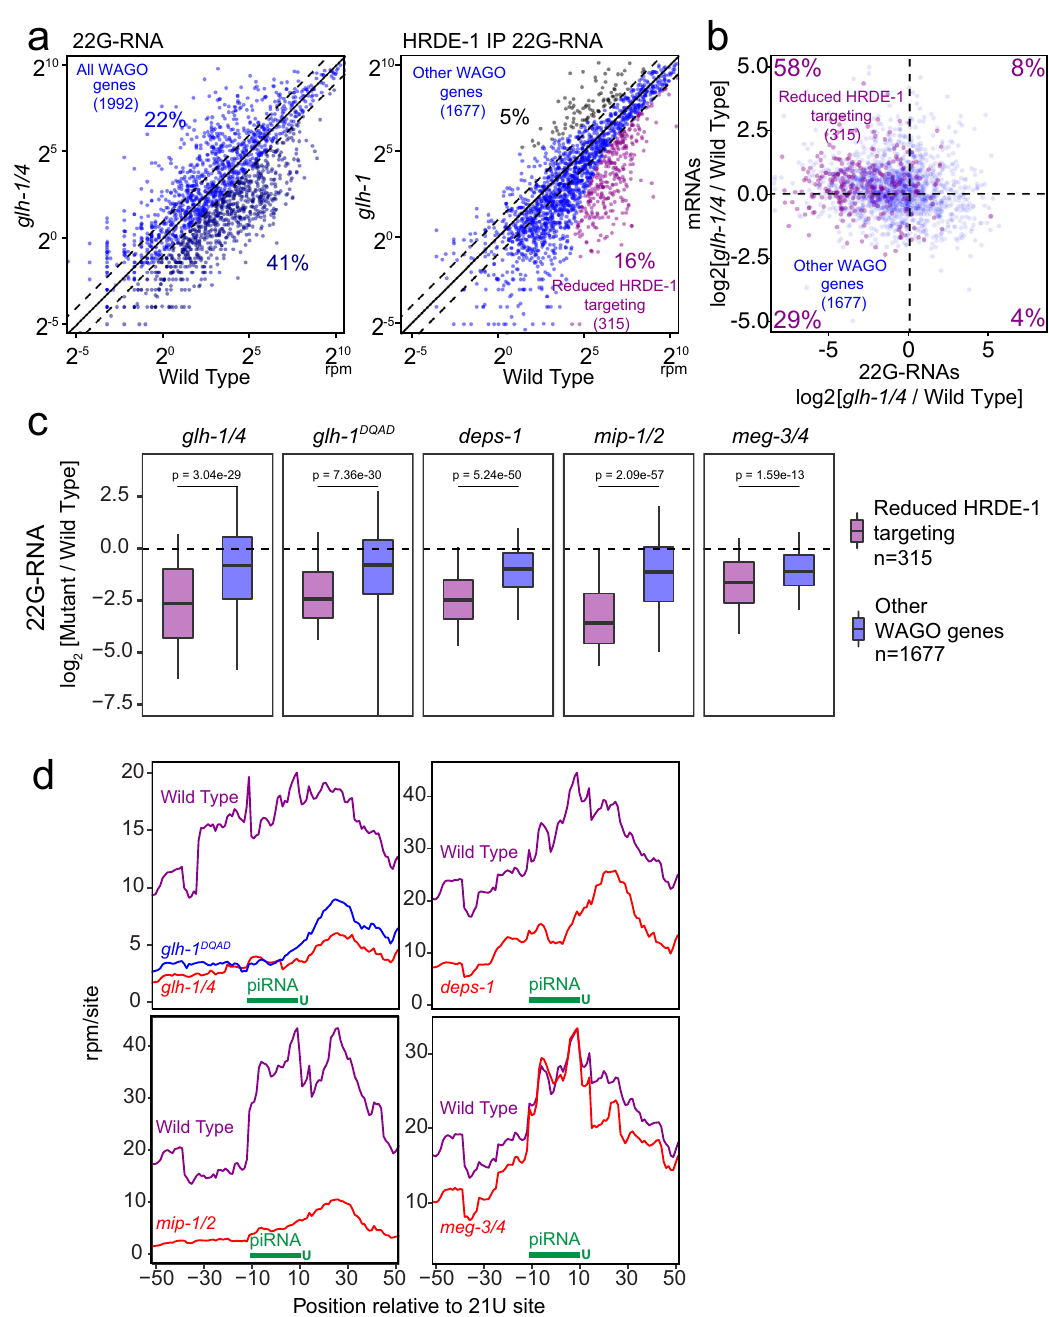
Fig.4|GLH/VASAmutantsexhibitdefectsinproducingsecondaryWAGO-22G- RNAs. a A scatter plot showing the abundance of all 22G-RNAs (left) or HRDE-1 bound 22G-RNAs (right) mapped to each WAGO target in wild-type worms com- pared to indicated strains. (Left) The percentage of WAGO targets with 2-fold increased ordecreased22G-RNAsinmutantsare shown.(Right)The percentage of signi fi cantly changed (adjusted P <0.05 [see Methods for details] and 2-fold) WAGO targets are shown. The three diagonal lines indicate a two-fold increase (top),nochange(middle),oratwo-folddepletion(bottom)intheindicatedmutant strains. b AscatterplotshowingthemRNAvs22G-RNAlog 2 expressionchangesfor WAGO targets in glh-1 glh-4 mutants vs wild type worms. The upper left quadrant correspondstoWAGOtargetsthathavebecomeactivatedinthemutant(increased mRNAs and decreased 22G-RNAs). Percentages are shown in each quadrant to